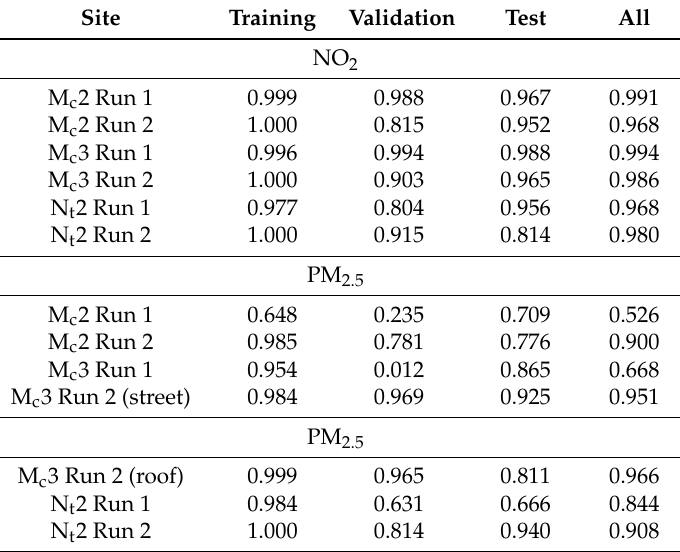
Table 2. Summary of Pearson R values for each run.